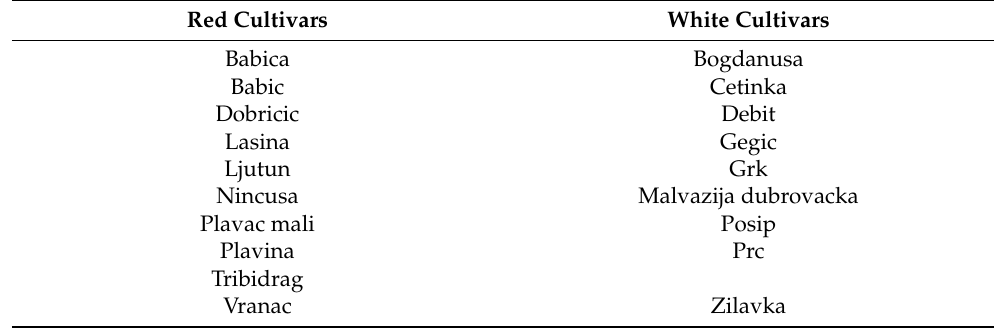
Table 1. The list of sampled grapevine